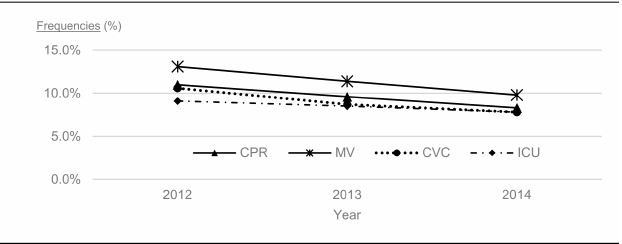
Figure 1. Annual trends in the administration of life-sustaining treatments and intensive care unit admissions in the last 7 days of life from 2012 to 2014. The vertical line represents the frequencies of administration of CPR, MV, CVC, and ICU admissions and the horizontal one year. Abbreviations: CPR: cardiopulmonary resuscitation, MV: mechanical ventilation, CVC: central venous catheter insertion, ICU: intensive care